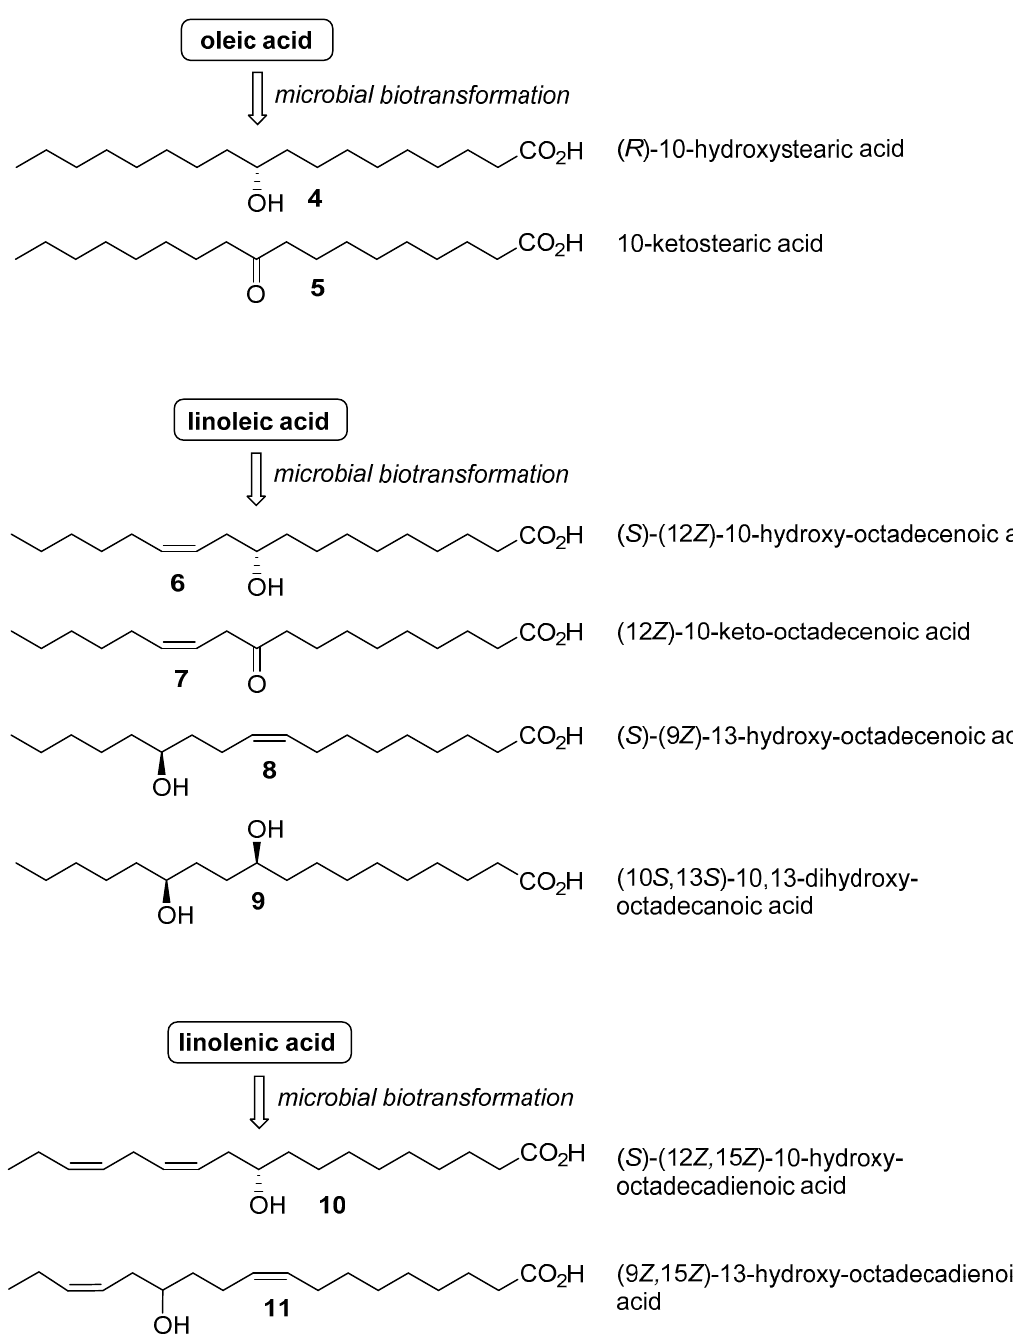
Figure 2. The hydration-based biotransformations of the oleic ( 1 ), linoleic ( 2 ), and linolenic ( 3 ) acids, potentially mediated by probiotic bacteria.